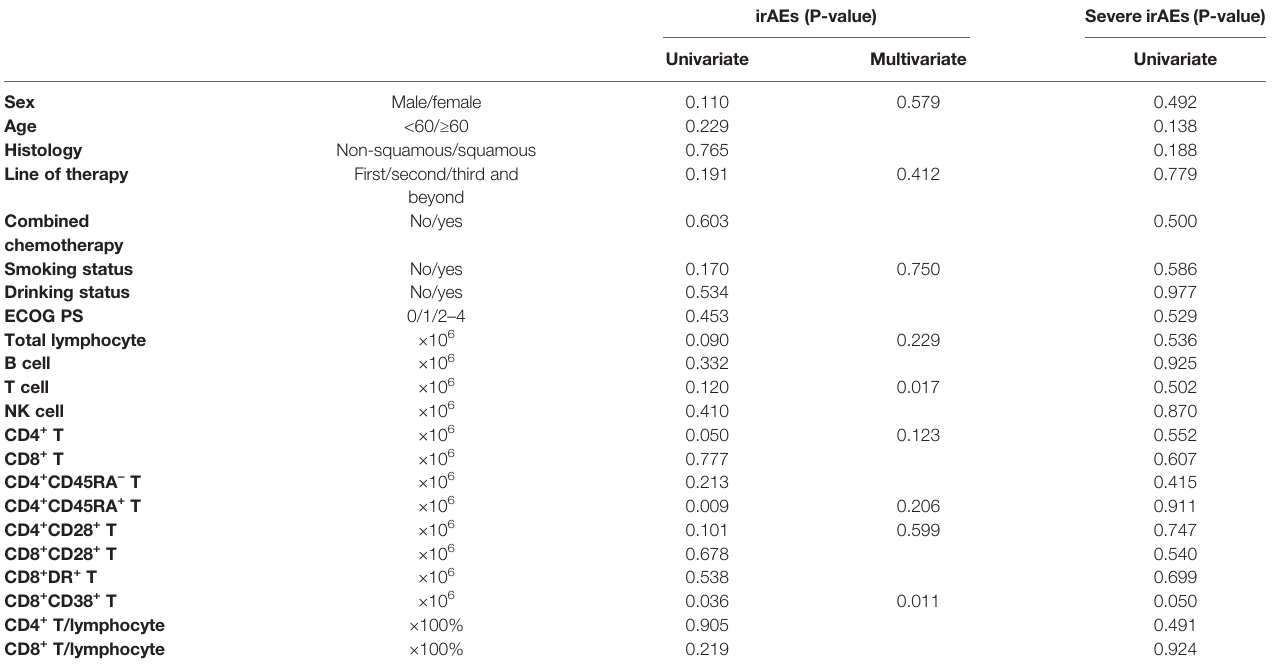
TABLE 5 | Logistic regression of